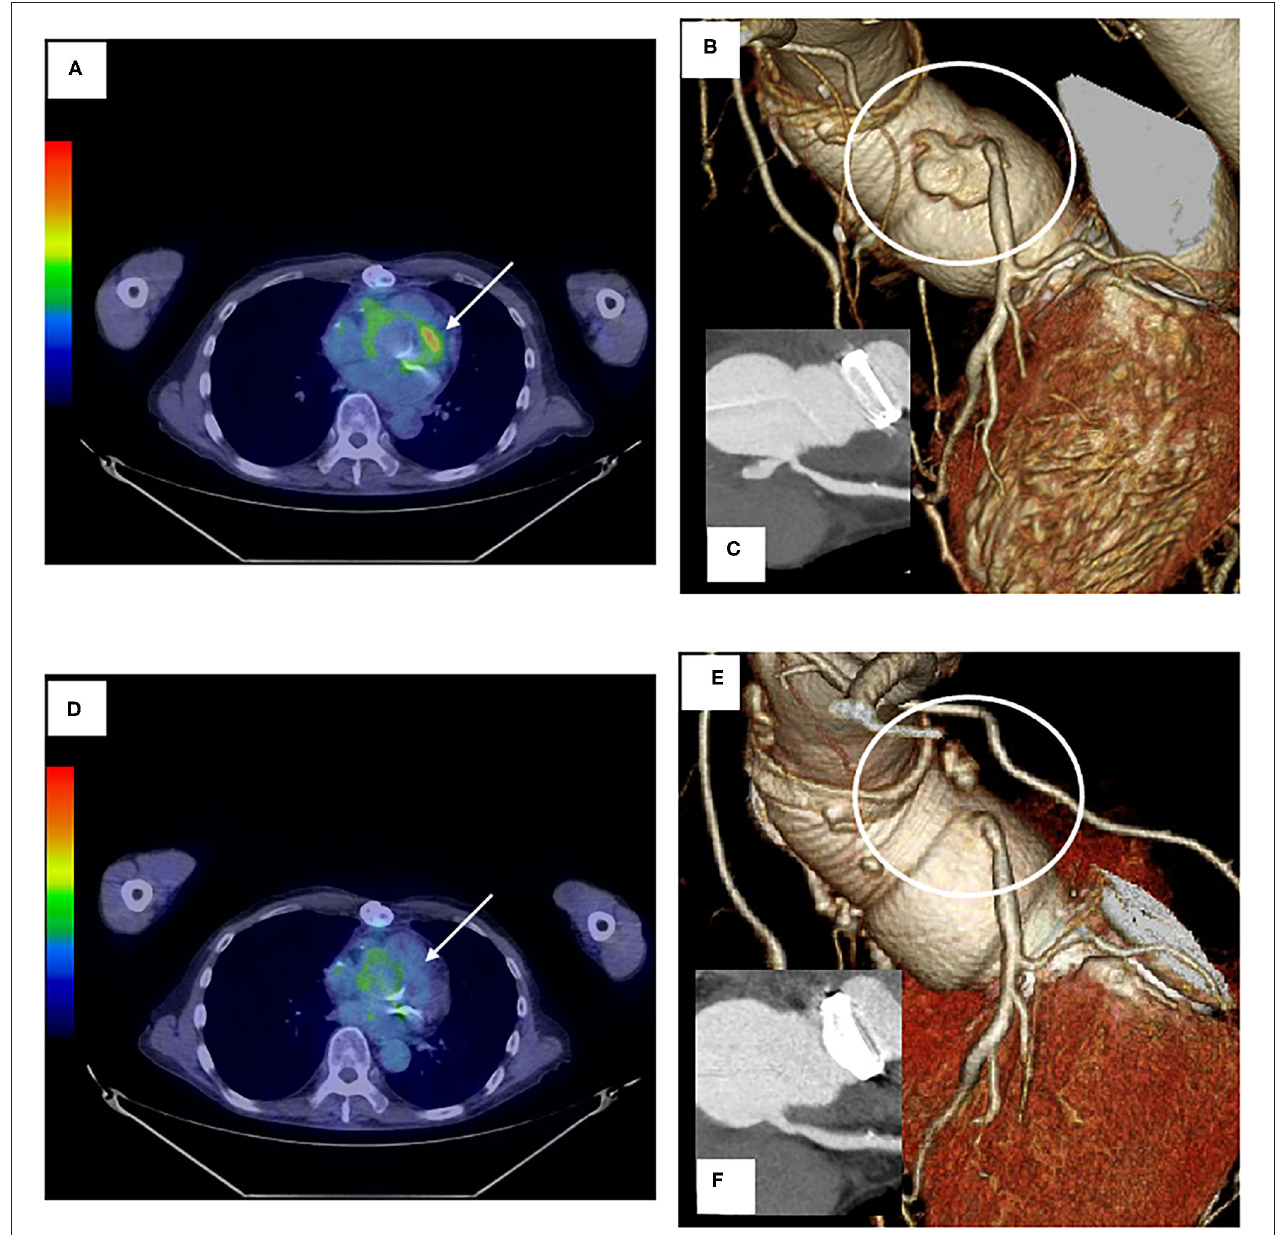
FIGURE 2 | (A,D) Images of 18 F-fluorodeoxyglucose ( 18 F-FDG) positron emission tomography/computed tomography before (A) and after (D) steroid therapy. Arrows indicate the anastomotic site with left coronary artery aneurysm. (B,C,E,F) 3D coronary angiography and contrast-enhanced CT images before (B,C) and after steroid administration (E,F)